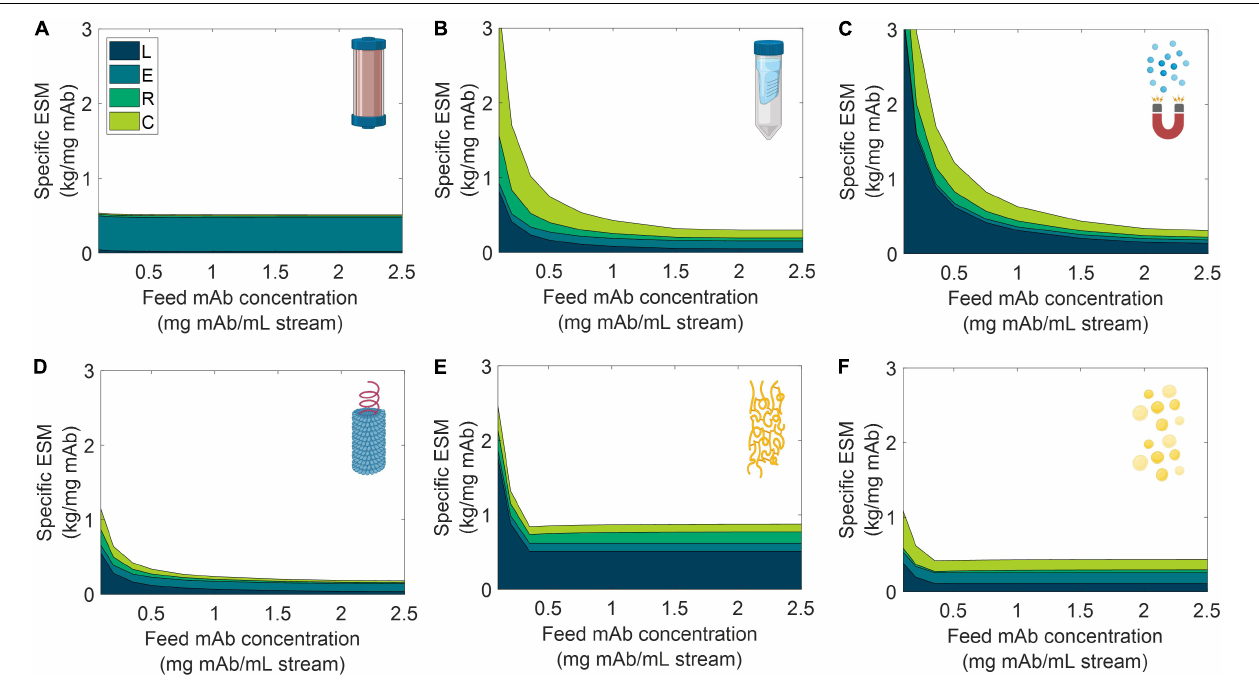
FIGURE 6 | Specific equivalent system mass (per unit mass monoclonal antibody produced) broken down by labor (L), equipment (E), raw materials (R), and consumables (C) cost categories as a function of feed monoclonal antibody (mAb) concentration for (A) CHM, (B) SPN, (C) MAG, (D) VIN, (E) ELP, and (F) OLE. CHM, pre-packed chromatography; SPN, spin column; MAG, magnetic bead; VIN, plant virus-based nanoparticle; ELP, elastin-like polypeptide; OLE,